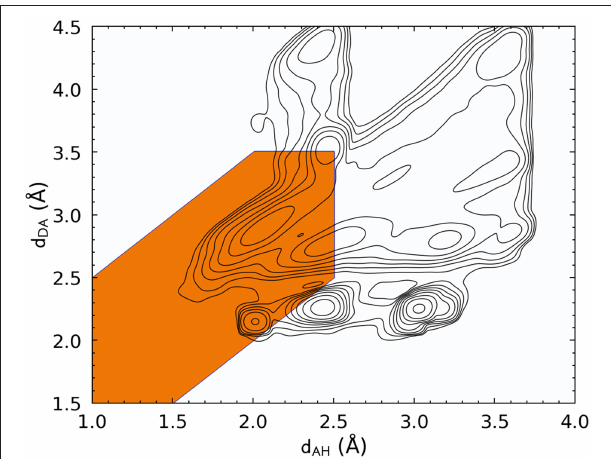
FIGURE 1 | Histogram of the acceptor–hydrogen and donor–acceptor distances across all hydrogen bond flavors, plotted with log-spaced contours. The maximum at ( d AH ≈ 2.1Å, d DA ≈ 2.8Å) corresponds to the typical H-bond range. Other maxima are associated with other structural features, such as covalently bound groups on the side chains, geometries in which the two electronegative atoms are in the same residue, or configurations in which the hydrogen atom is not bound to the donor. The orange-shaded area corresponds to the distance-angle PMI as defined in Equation 3.